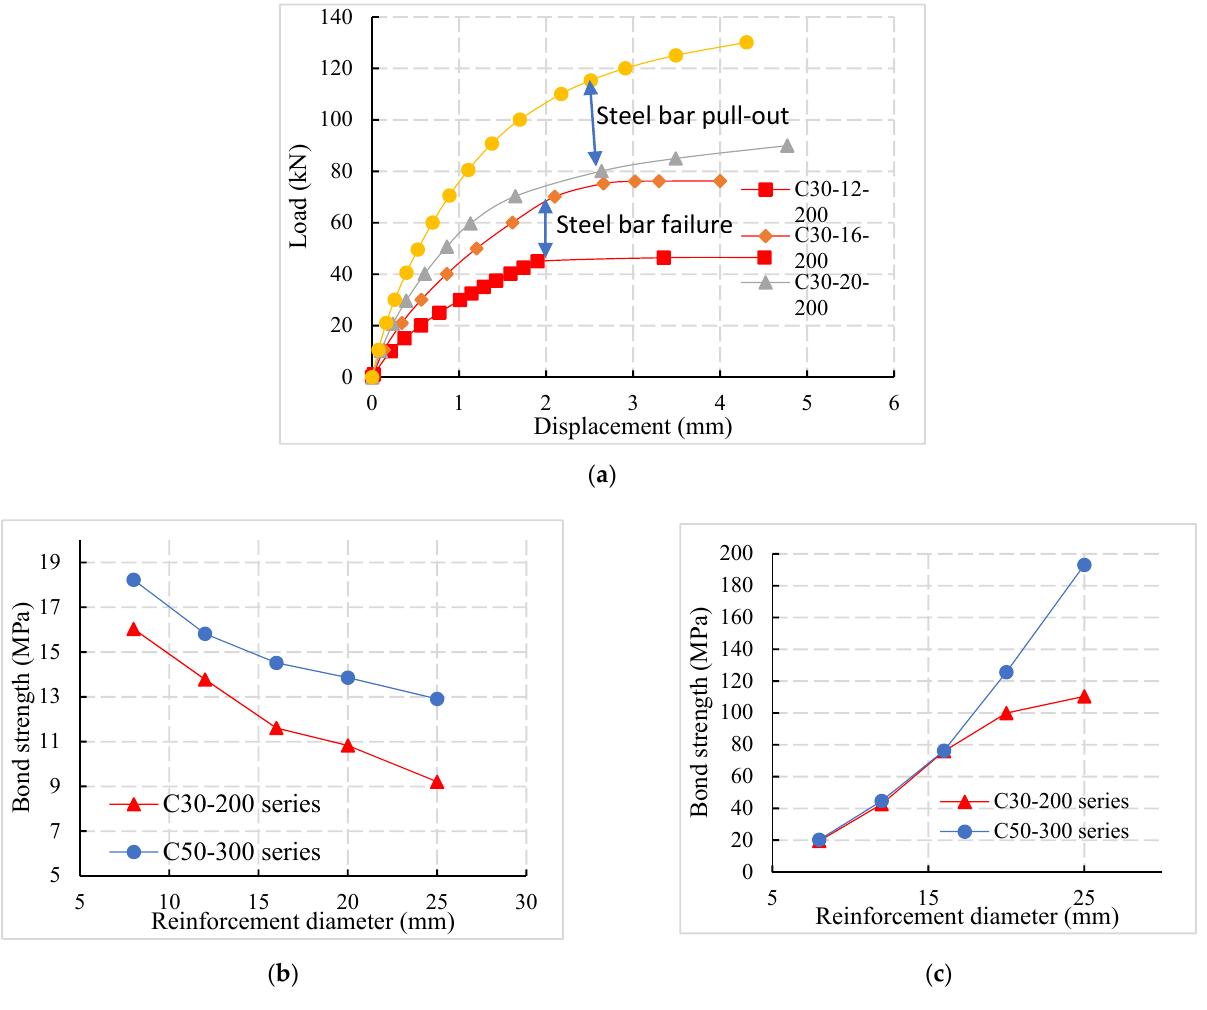
Figure 13. ( a ) Comparison of load-displacement curves of specimens with different reinforcement diameters. Influence of steel bar diameter: ( b ) Bond strength and steel bars diameter; ( c ) Ultimate load and steel bars diameter.